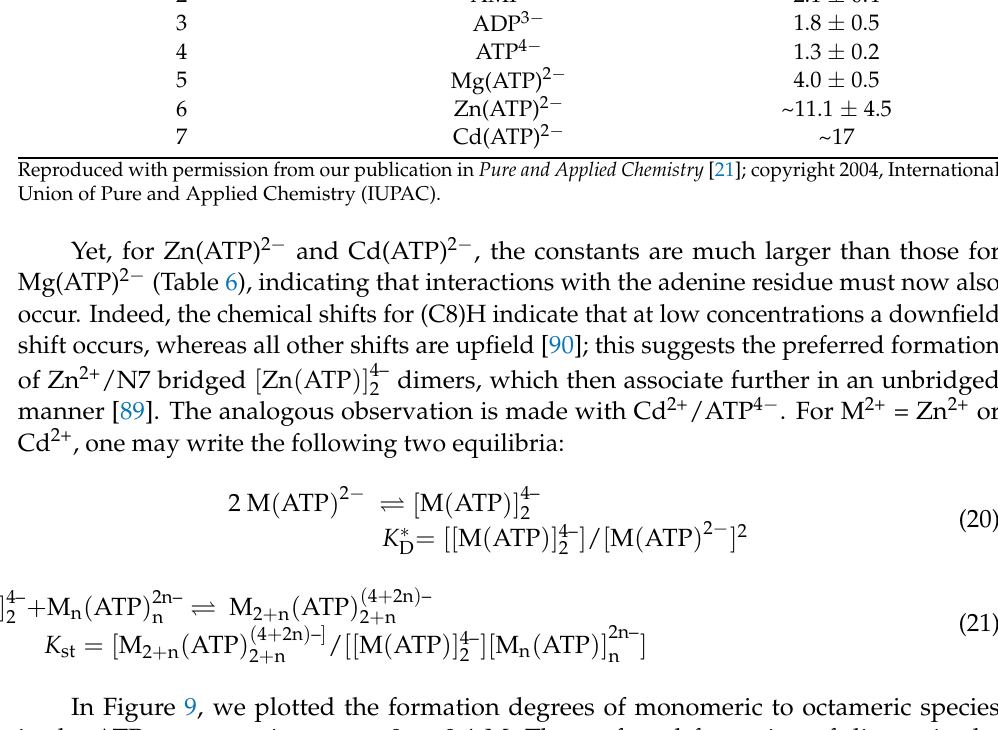
Table 6. Equilibrium constants defined according to the isodesmic model for a non-cooperative self-association for the self-stacking (Equations (18) and (19)) of adenosine and its 5 (cid:48) -phosphates as well as of M(ATP) 2 − complexes, as determined by 1 H NMR shift measurements [90,94] in D 2 O (27 ◦ C; I = 0.1 − ~2 M NaNO 3 ) (error limits: 2 σ ). No. System K (M − 1 ) 1 Ado 15 ± 2 2 AMP 2 − 2.1 ± 0.4 3 ADP 3 − 1.8 ± 0.5 4 ATP 4 − 1.3 ± 0.2 5 Mg(ATP) 2 − 4.0 ± 0.5 6 Zn(ATP) 2 − ~11.1 ± 4.5 7 Cd(ATP) 2 −